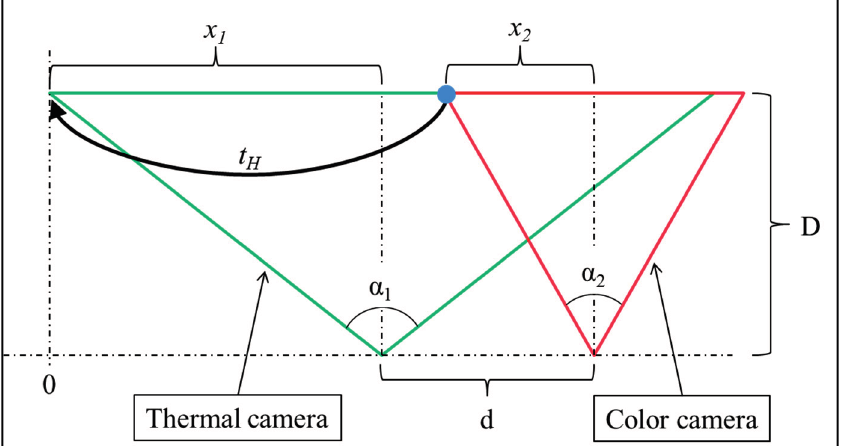
Figure 9. Horizontal translation